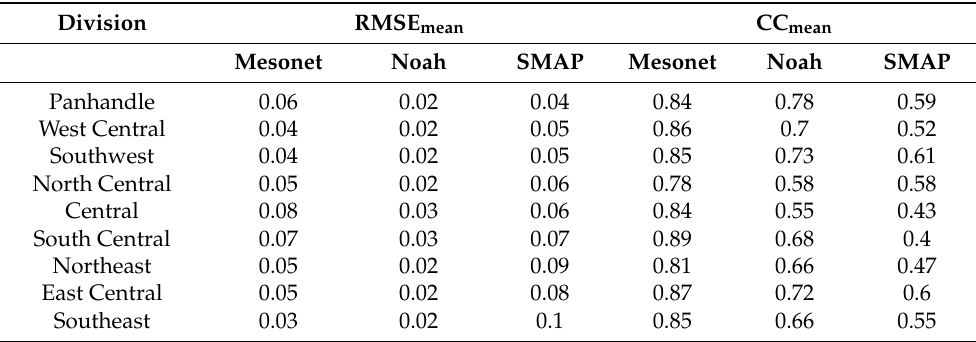
Table 8. Climate-division averaged CC and RMSE from the TC triplets at local 6:00 a.m. values from April 2015 to July 2019, for Mesonet, Noah, and SMAP during the winter season months (i.e., December, January, and February) for nine climate divisions in Oklahoma. Division RMSE mean